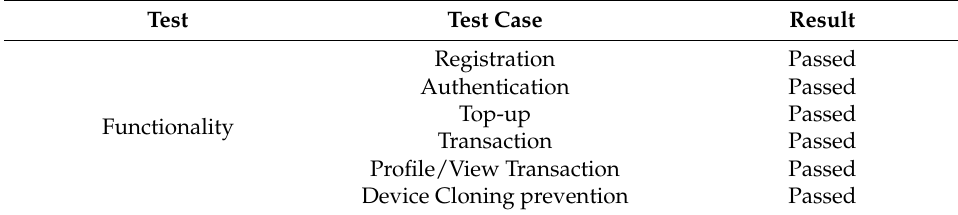
Table 8. Functionality test of